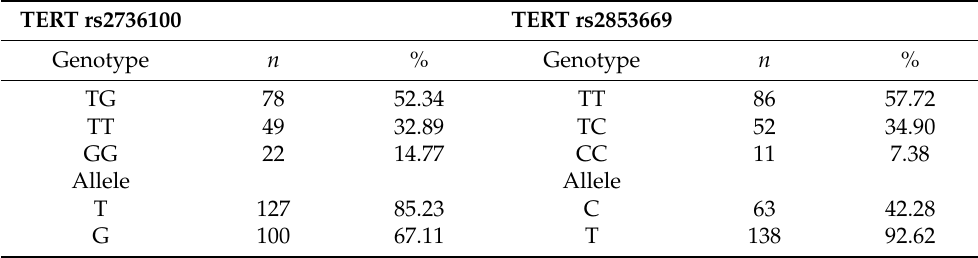
Table 2. The prevalence of TERT SNP in the entire study